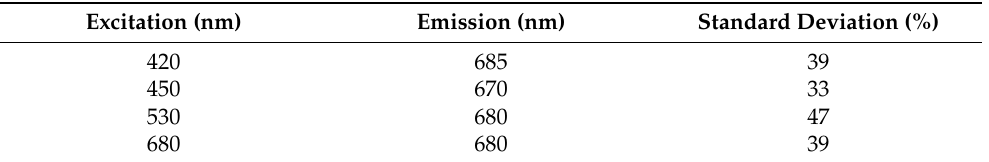
Figure 4. Standard deviation of the excitation/emission fluorescence values corresponding to Nan- nochloropsis gaditana , Isochrysis galbana and Tetraselmis suecica , calculated with Equation (1). The peaks represent the excitation/emission pairs where fluorescence differs in these three species. Excitation and emission wavelengths are plotted in horizontal axis and standard deviation (as percentage of mean value) in vertical axis. Table 4. Pairs of excitation/emission wavelengths where difference between fluorescence of spectrum is higher, using the standard deviation as selection criteria.